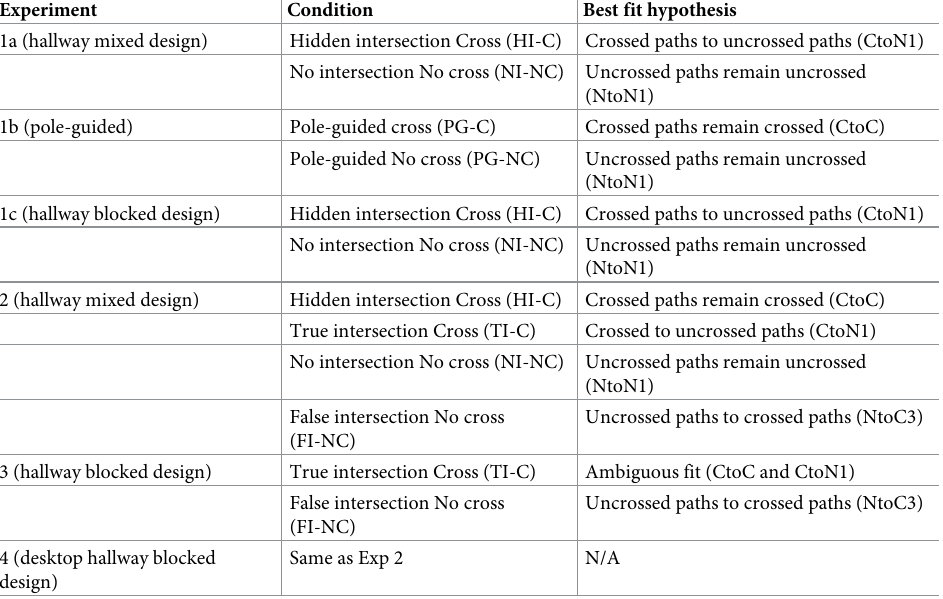
Table 3. Summary of results in all